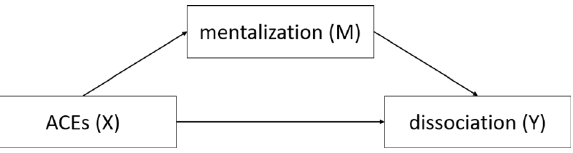
Figure 1. Theoretical model of the moderating effect of mentalization on the relationship of ACEs and